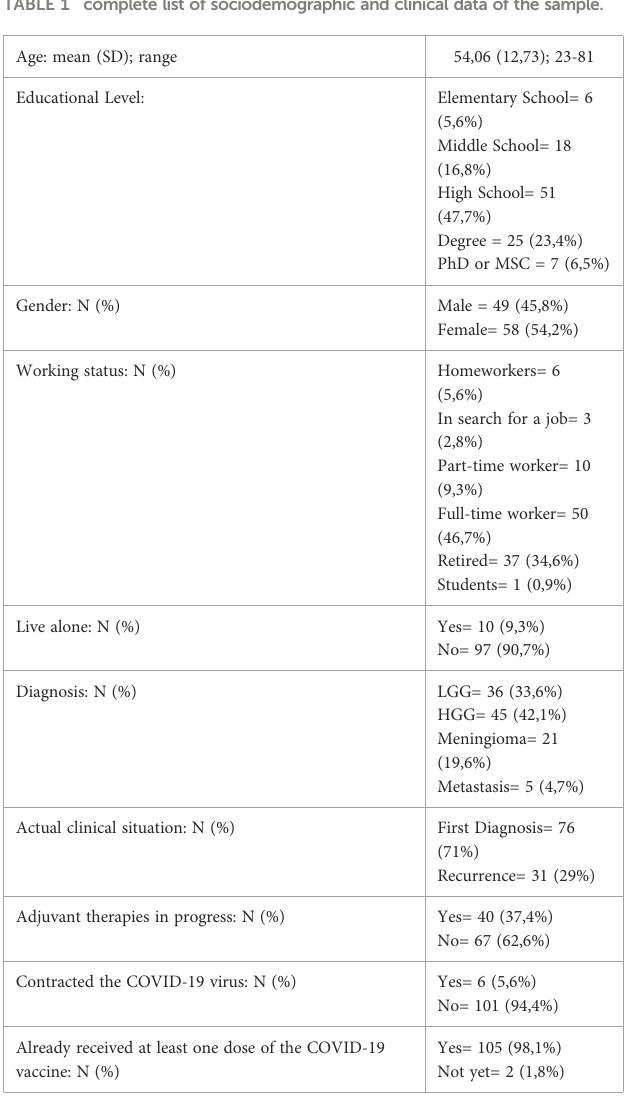
TABLE 1 complete list of sociodemographic and clinical data of the